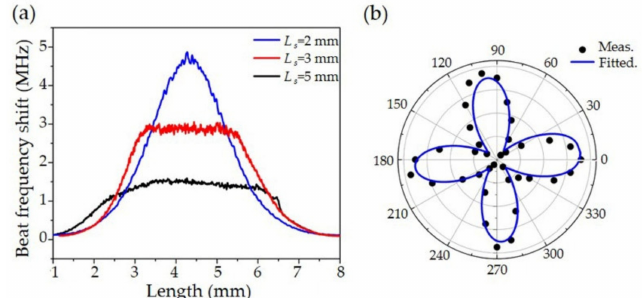
Figure 9. Measured acoustic responses along ( a ) longitudinal and ( b ) azimuthal direction. Figure adapted with permission from Ref.